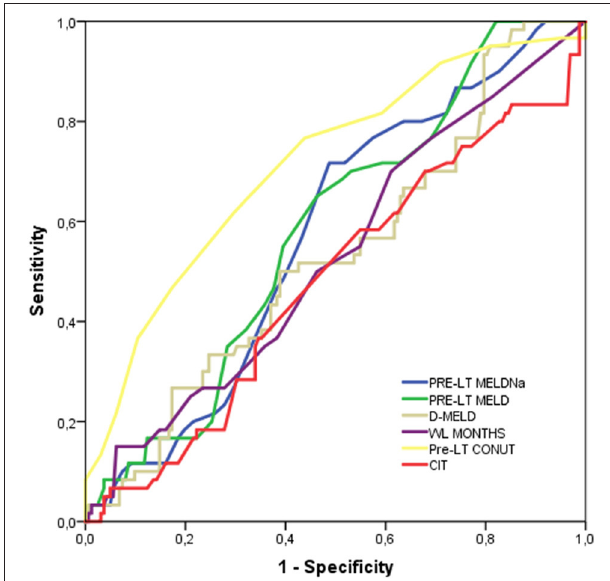
FIGURE 3 | Harrel’s c-statistics for the diagnosis of CCI